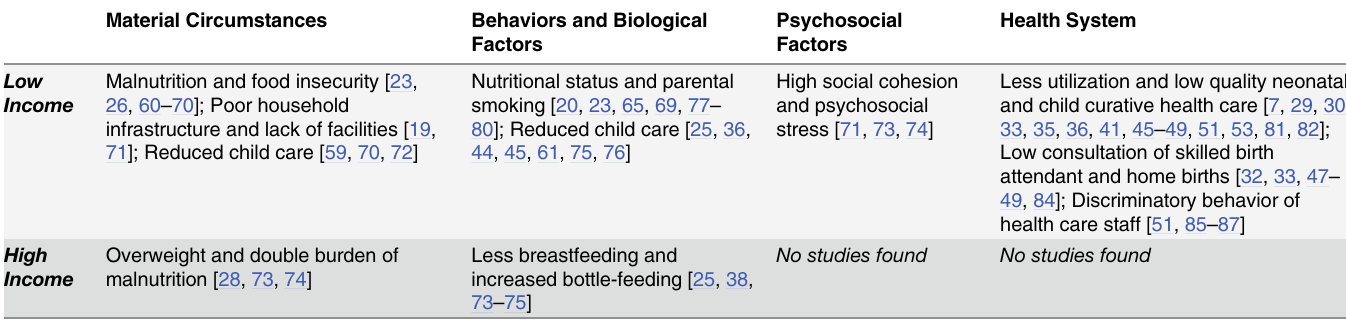
Table 2. Income and Child Health in